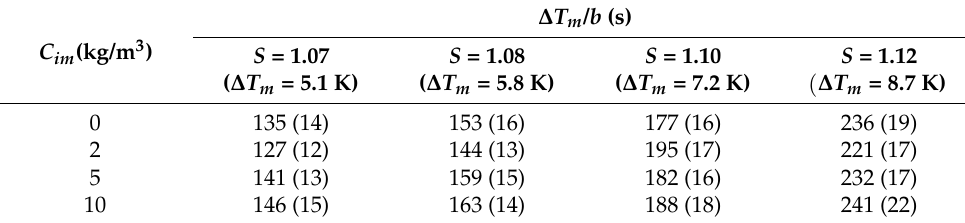
Table 2. The average lag time, ∆ T m / b , based on b ∼ = 0.038 K/s in the induction time measurements for various impurity concentrations, C im , and supersaturations, S , at 303 K, where ∆ T m corresponds to the temperature range for a solution with concentration C 0 saturated at T 0 and cooled to 303 K. Note that ∆ T m = T 0 − 303 K and S = C 0 / C eq ( 303 K ) . The standard deviations in the least significant digits are given in parentheses.